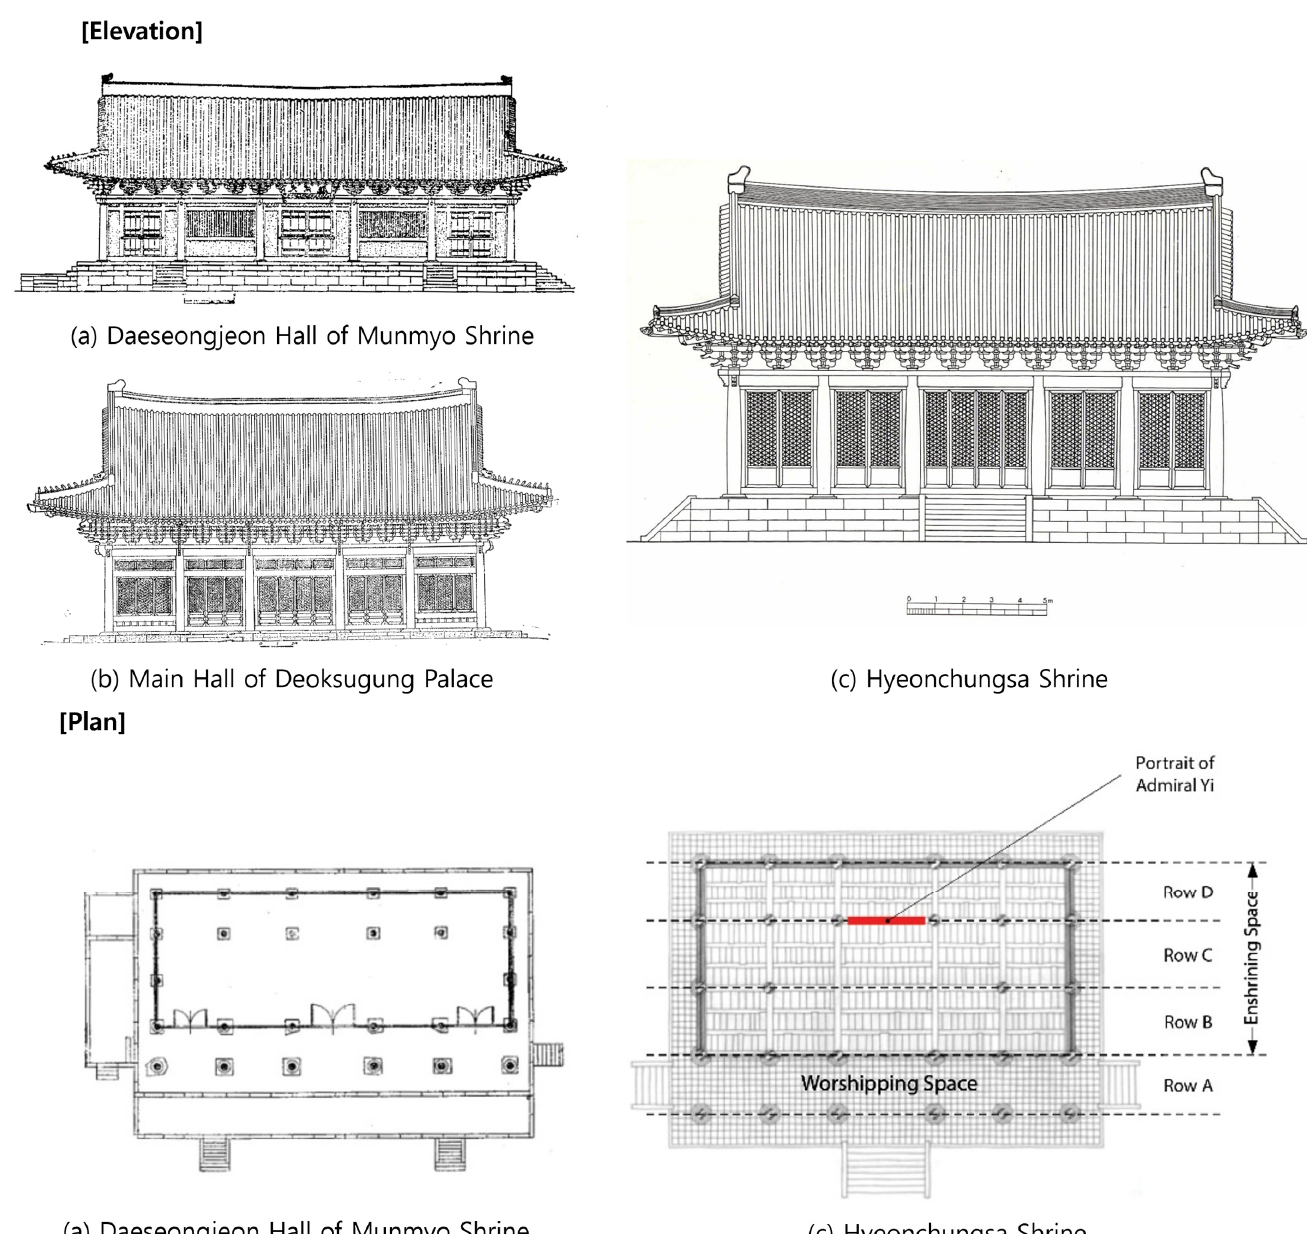
Figure 8. Comparison between the design proposal of the ( c ) Hyeonchungsa shrine and ( a ) Daeseongjeon Hall of Munmyo shrine and ( b ) Main Hall of Deoksugung Palace (elevation and plan, not drawn in scale) (Source: Bong-jin Kang, Cultural Heritage Administration).